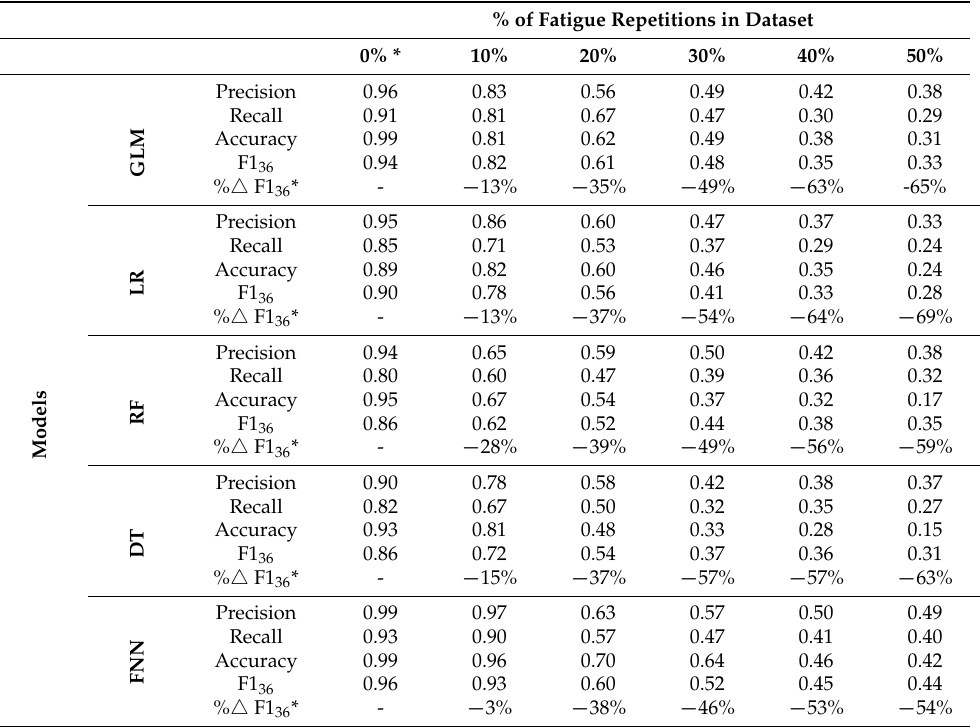
Table 9. The performance averages for subject-specific models to detect biceps repetitions, using the 36 features, throughout the incremental replacement of fatigue repetitions.